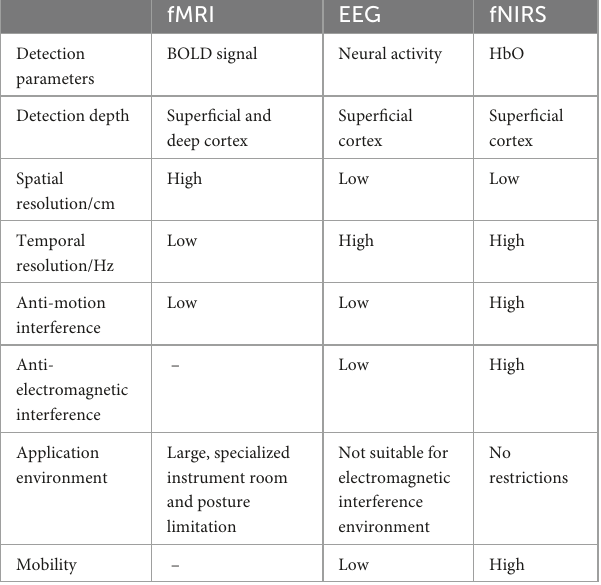
TABLE 1 Comparison of mainstream functional brain imaging techniques. fMRI EEG fNIRS